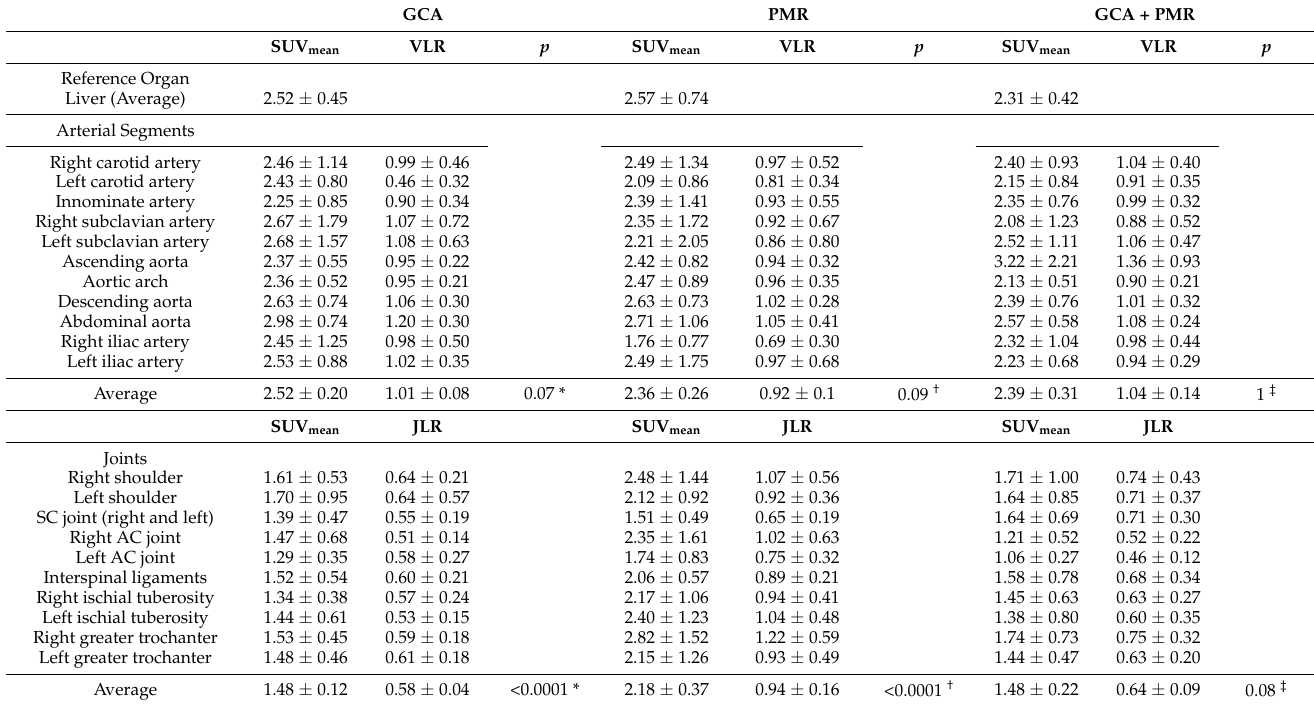
Table 2. Semiquantitative